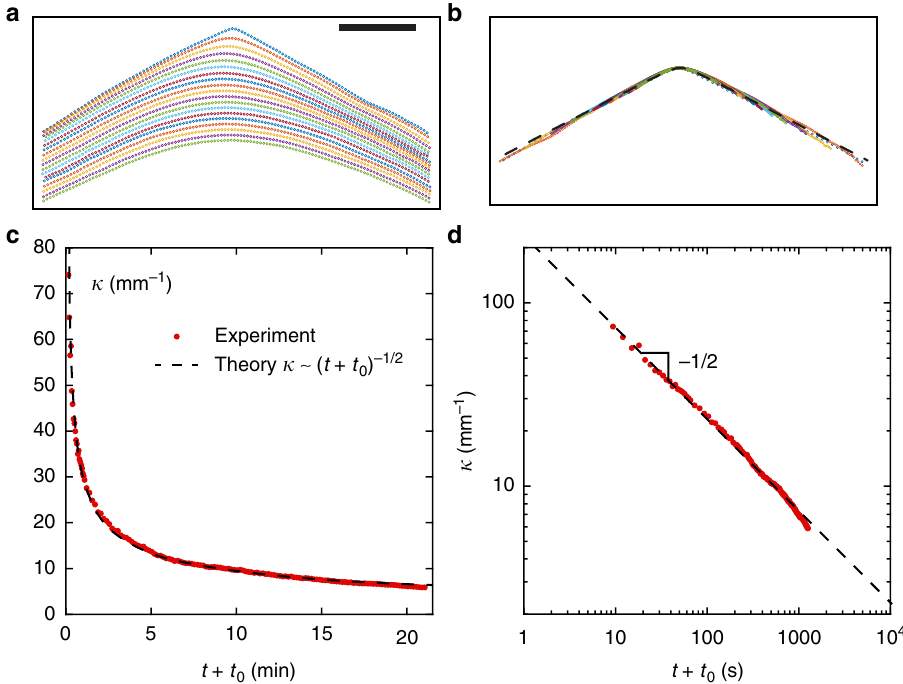
Fig. 4 Tip smoothing. a Experimental tip pro fi les taken every 2 min during the fi rst half hour of an experiment (see Supplementary Movie 4; V 0 = 3.5 μ L, T = − 12 °C, RH = 5.1%). Scale bar 100 μ m. b Same pro fi les multiplied by the tip curvature κ . The dashed black line is a hyperboloid. c Tip curvature at s short times ( T s = − 15 °C, RH = 4.6%). The dashed line is a fi t of our similarity solution: κ = A ( t + t 0 ) − 1/2 with A = 2.32 ⋅ 10 5 s 1/2 m − 1 ( t 0 = ( A / κ (0)) 2 = 9s). d Same data on a log-log